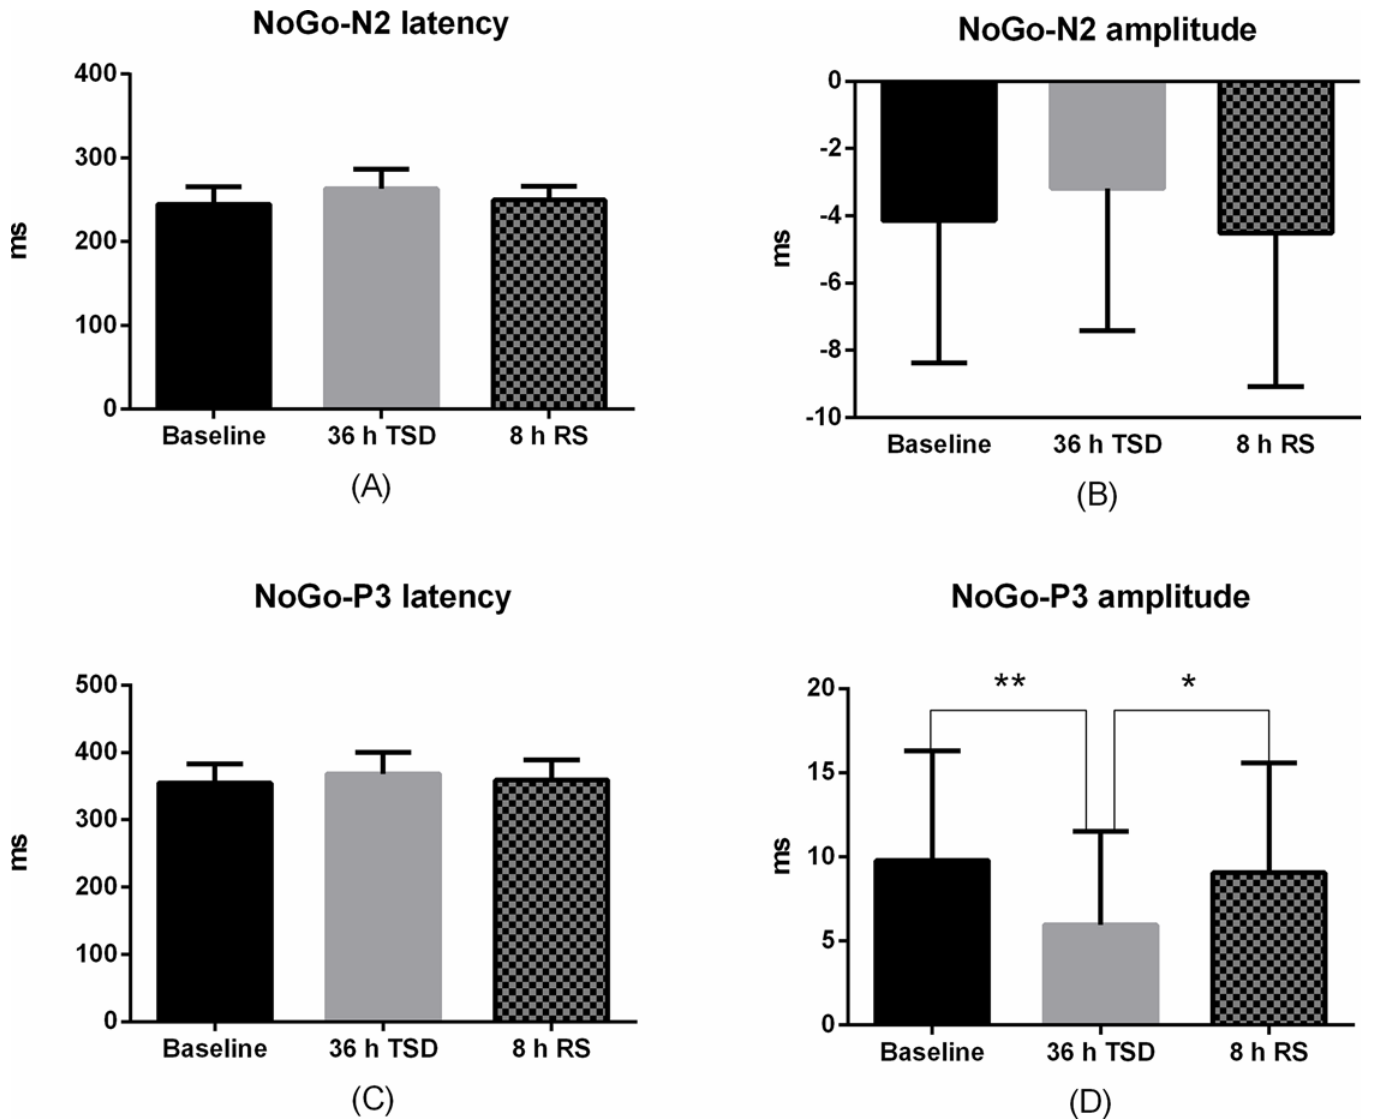
Fig 5. ERP components differences between Baseline, 36 h TSD and 8 h RS. Baseline: before total sleep deprivation session, 36 h TSD: after 36 hours of total sleep deprivation, 8 h RS: after 8 hours of recovery sleep. (A) The mean of NoGo-N2 latency in Baseline, 36 h TSD and 8 h RS. (B) The mean of NoGo-N2 amplitude in Baseline, 36 h TSD and 8 h RS. (C) The mean of NoGo-P3 latency in Baseline, 36 h TSD and 8 h RS. (D) NoGo-P3 amplitude in Baseline, 36 h TSD and 8 h RS. The error bars represent standard deviation. * : p < 0.05 (uncorrected), ** p < 0.025 (corrected), corrected multiple comparison